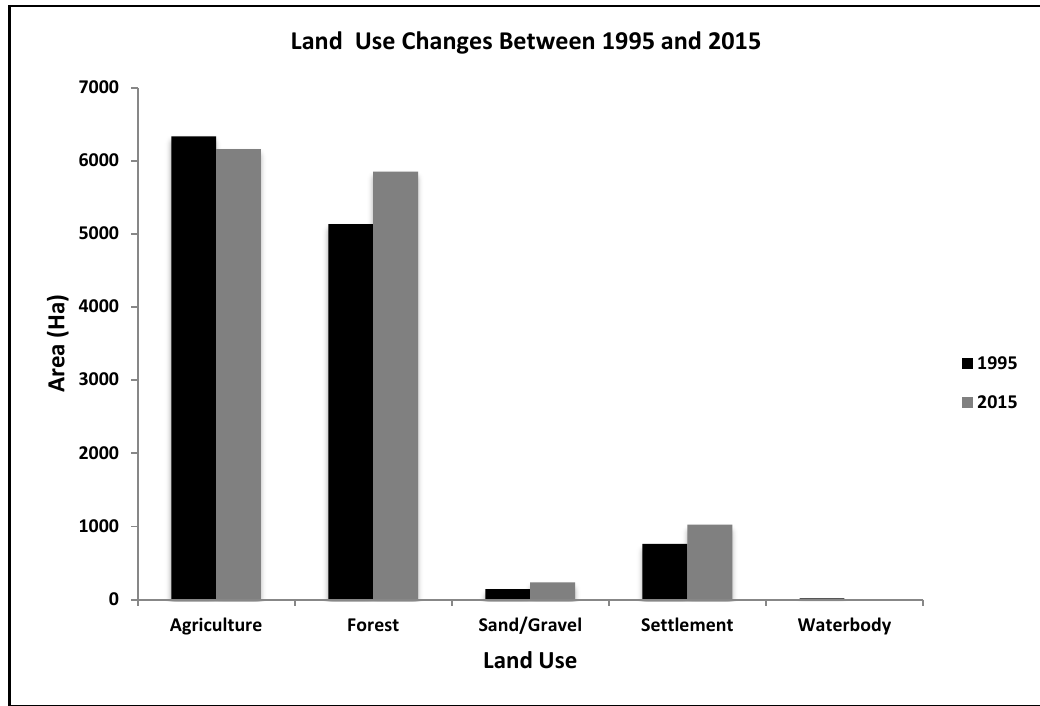
Figure 8. Land use changes between 1995 and 2015.